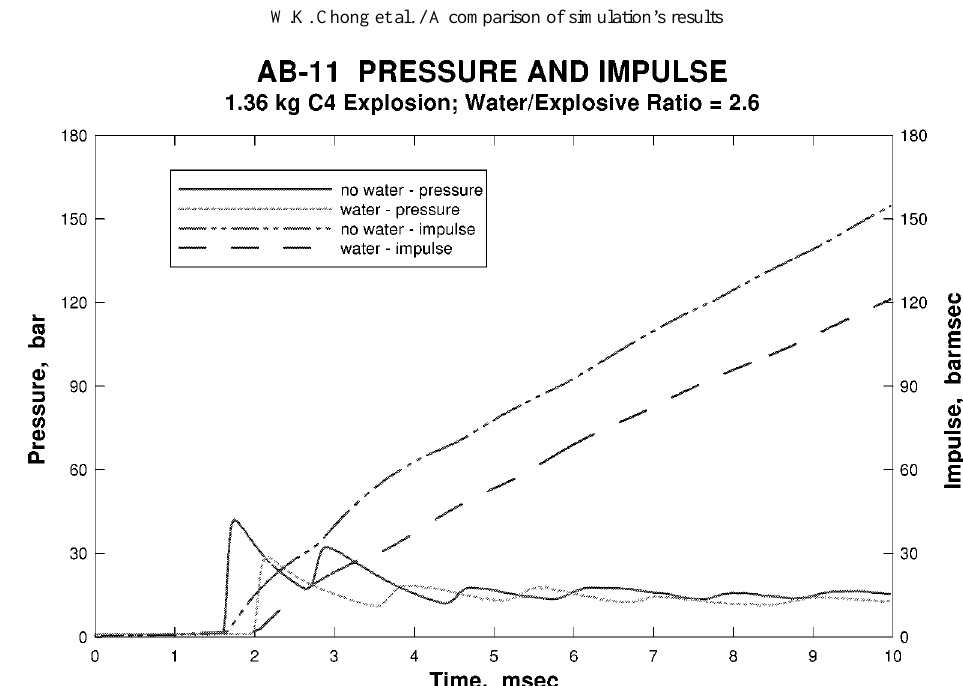
Fig. 15. Pressure and impulse versus time of computation for 1.36 kg C4 charge detonation with water-explosive ratio of 2.6 for location